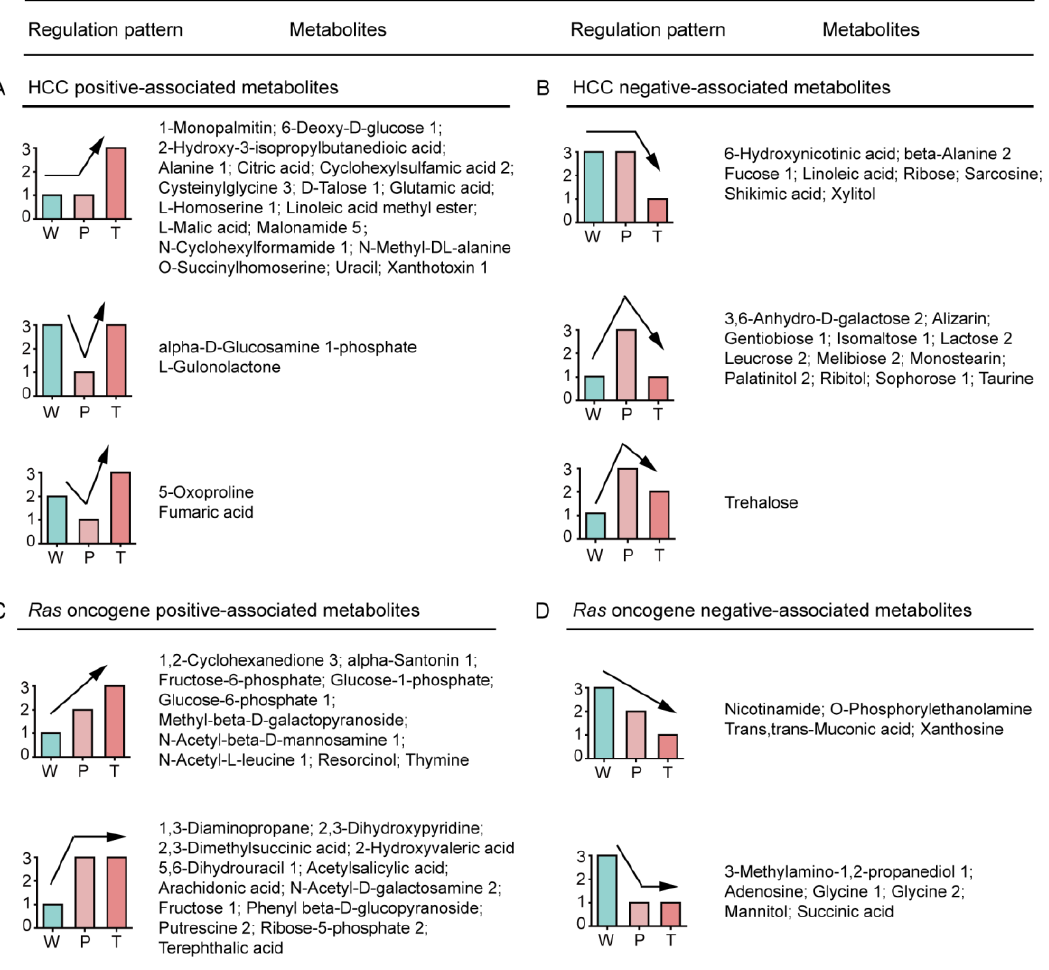
Figure 1. Expression-pattern analysis of W, P, and T metabolites in Ras oncogene-induced hepatocarcinogenesis. ( A , B ) The positively and negatively associated metabolites of HCC, respectively. ( C , D ) The positively and negatively associated metabolites of Ras oncogene, respectively. A detailed description is provided in Table S1. W: normal liver tissue of wild-type mice; P: precancerous tissue of Ras -Tg; T: hepatocellular carcinoma tissue of Ras -Tg; Ras -Tg: Hras12V transgenic mice; HCC: hepatocellular carcinoma.